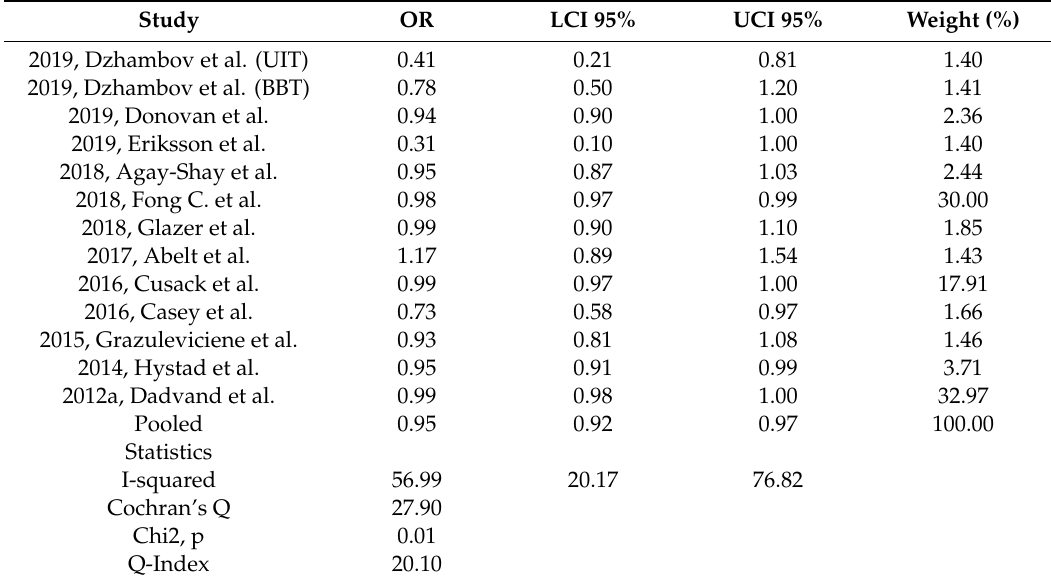
Table 2. Meta-Analysis Results for the effect of NDVI increase on small for gestational age (odds